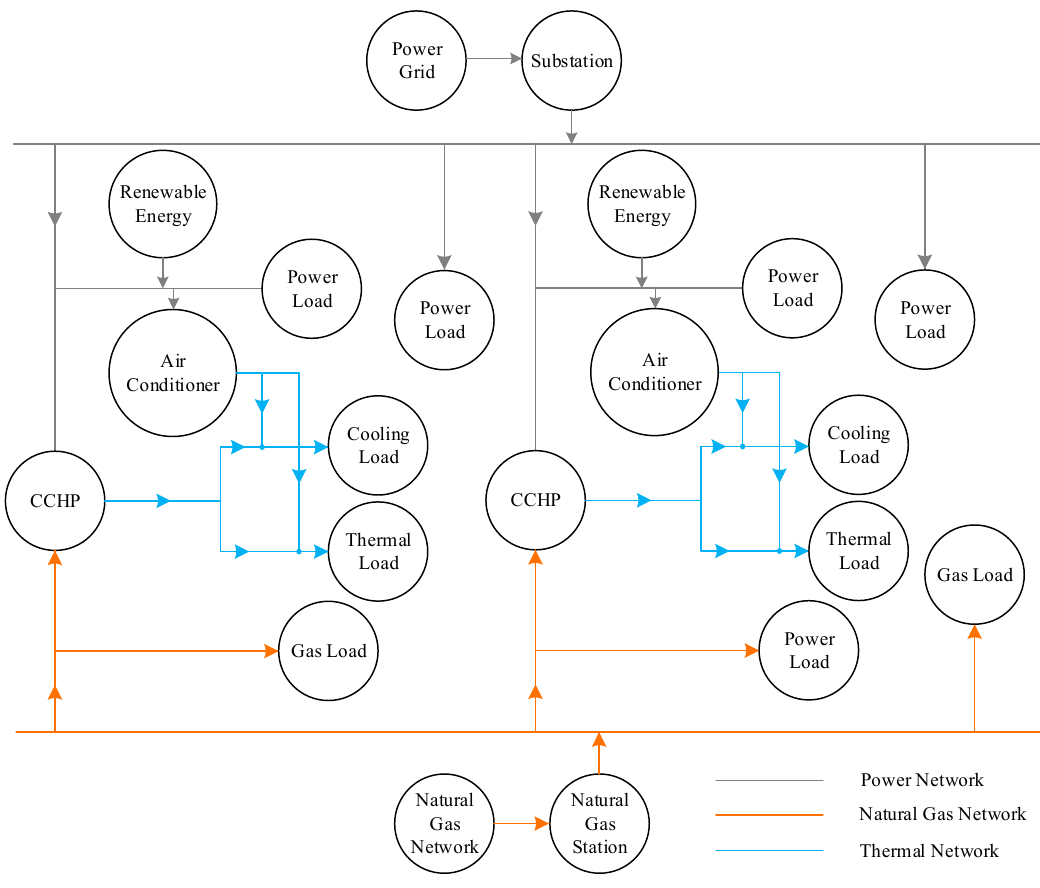
Figure 1. IES Physical planning model.